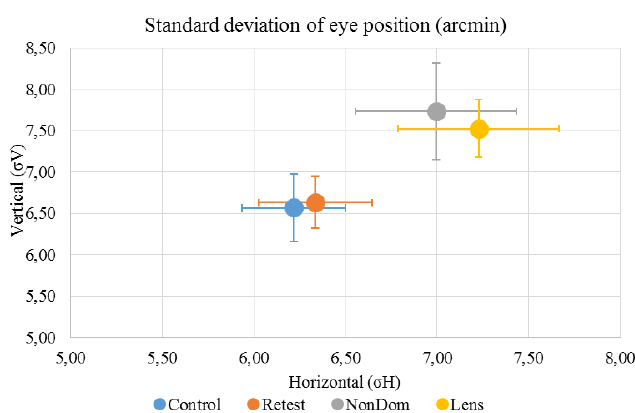
Figure 2. Mean (±standard deviation) horizontal standard deviation (σ H ) was 6.22 (±1.04) arcmin for the ‘Control’ condition, 6.34 (±1.03) arcmin for the ‘Retest’ condition, 7.00 (±1.46) arcmin for the ‘NonDom’ condition and 7.23 (±1.46) arcmin for the ‘Lens’ condition. Mean (±standard deviation) vertical standard deviation (σ V ) was 6.57 (±1.40) arcmin for the ‘Control’ condition, 6.63 (±1.05) arcmin for the ‘Retest’ condition, 7.73 (±1.95) arcmin for the ‘Non- Dom’ condition and 7.53 (±1.17) arcmin for the ‘Lens’ con- dition. Error bars represent the standard errors.